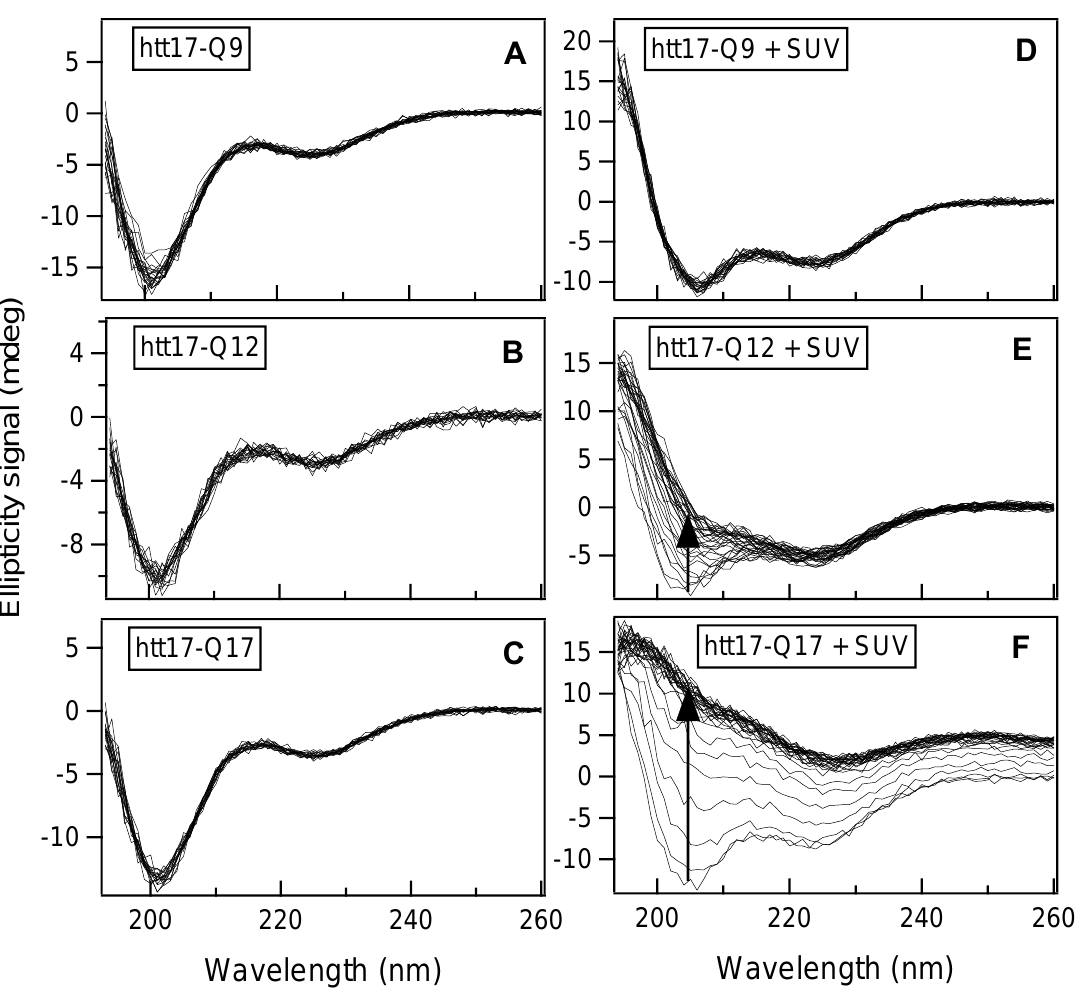
Figure 1. Time-dependent structural changes measured by circular dichroism: CD spectra of htt17-Q9, htt17-Q12 and htt17-Q17 (C = 9.1 × 10 −2 mg/mL) in 10 mM Tris-HCl, pH 7 ( A – C ), and in presence of SUVs made of POPC/POPS 3/1 mole/mole (C = 0.45 mg/mL) ( D – F ) were recorded every 24.5 min. The progress of the spectral changes with time is depicted by arrows in panels E and F . Thereby the peptide-to-lipid ratios are 1/19.6, 1/22, and 1/26 for htt17-Q9, htt17-Q12, and htt17-Q17, respectively.